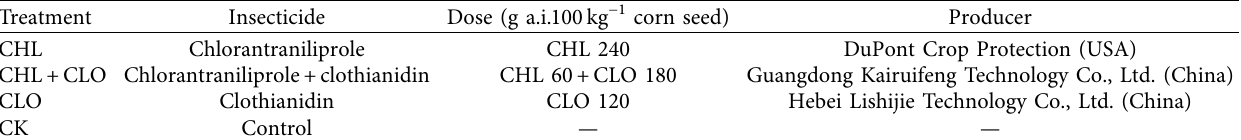
Table 1: Insecticides and dosages used in this